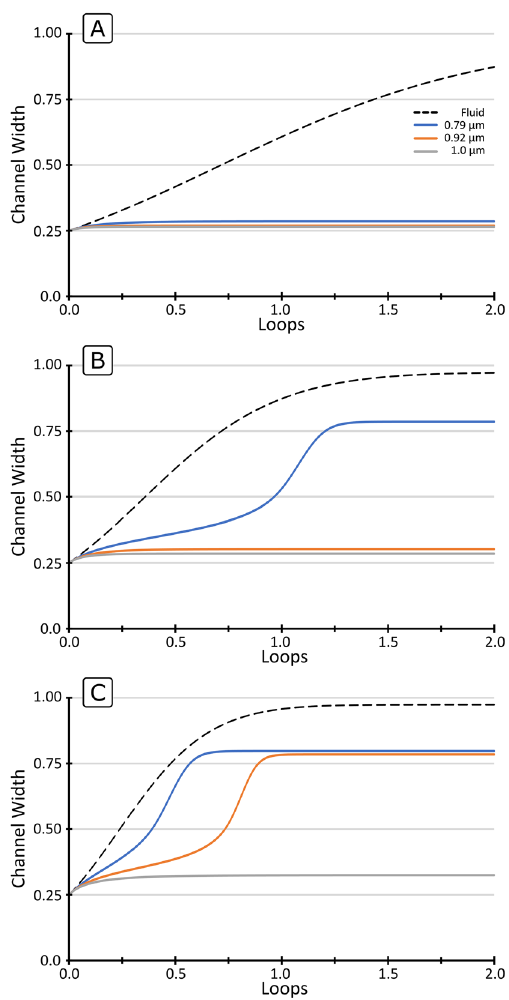
Figure 4. Trajectories of three particle sizes a (0.79, 0.92 and 1.0 µm) in sections with fixed R (200 µm), W (6.15 µm) and H (14.5 µm). ( A ) Q 10 µL/min, ( B ) Q 20 µL/min and ( C ) Q 30